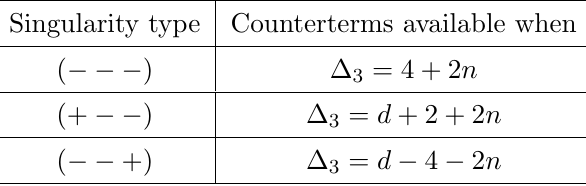
T (cid:22) O I i 1 (cid:22) 2 2 (cid:23) 2